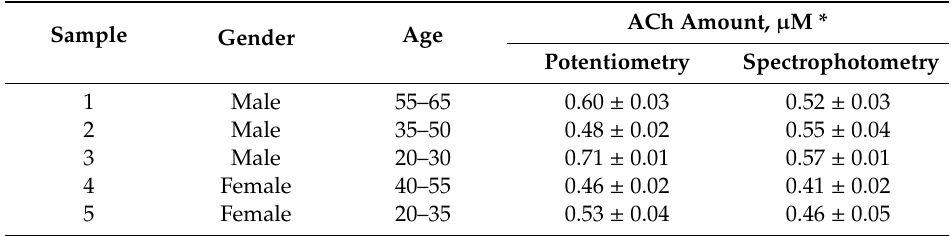
Table5. PotentiometricdeterminationofAChinhumanserumsamplesusingACh / TPB / PEDOT / PSS-ISE and